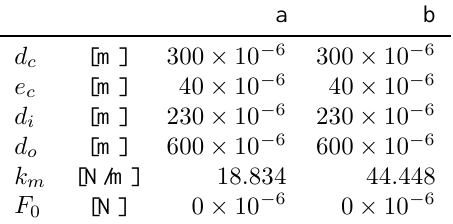
Table 2: Parameters of the various